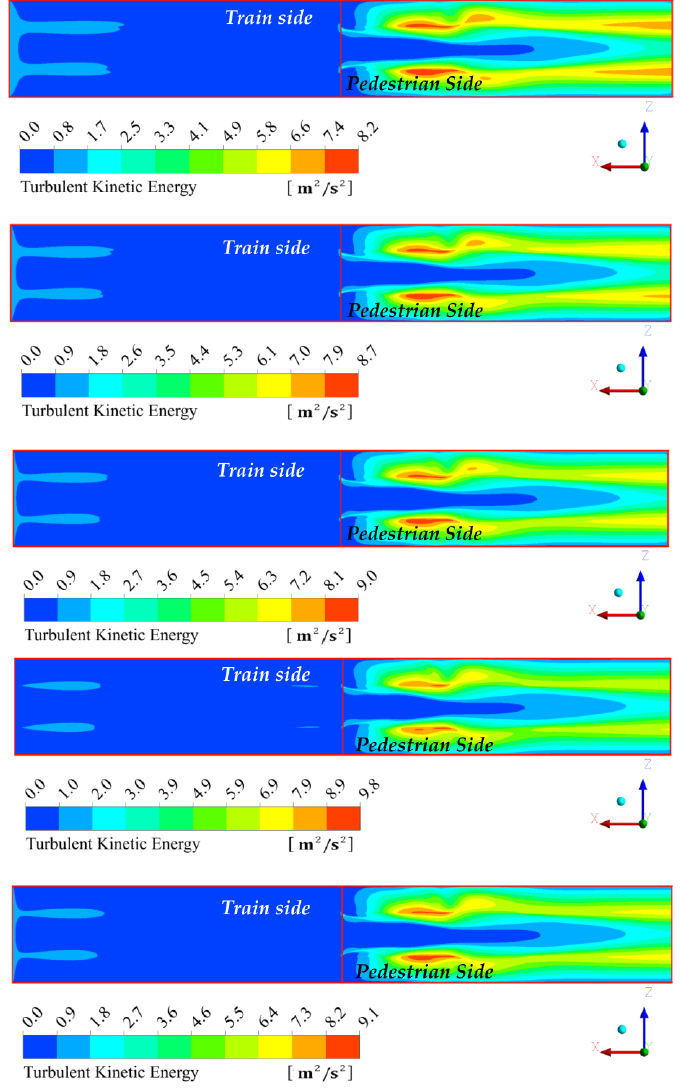
Figure 9. Turbulent kinetic energy distribution by porous media model along streamwise direction under different inflow boundary conditions. Substituting coefficients and